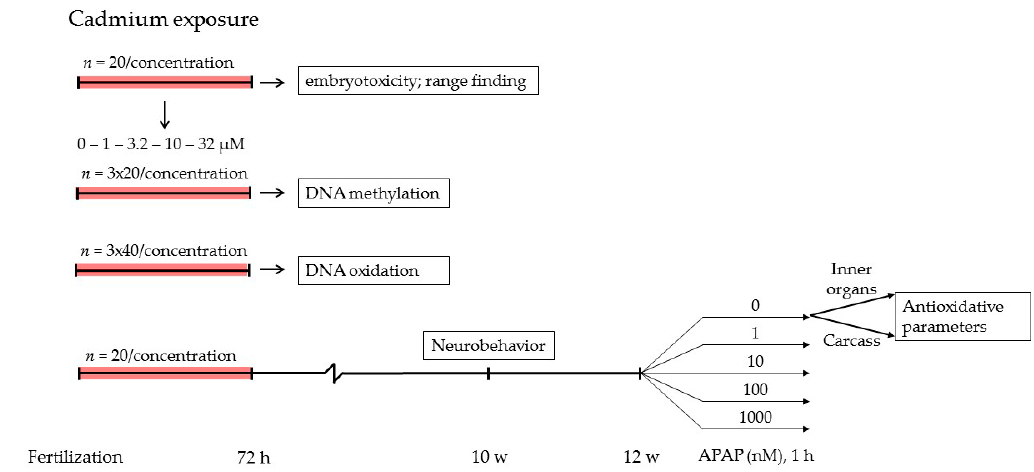
Figure 8. Workflow for the experiments in this study. Cadmium exposure was from 0–72 hpf in all experiments. Neurobehavioral analysis was started at 10 and antioxidative analysis at 12 weeks (w) post fertilization.